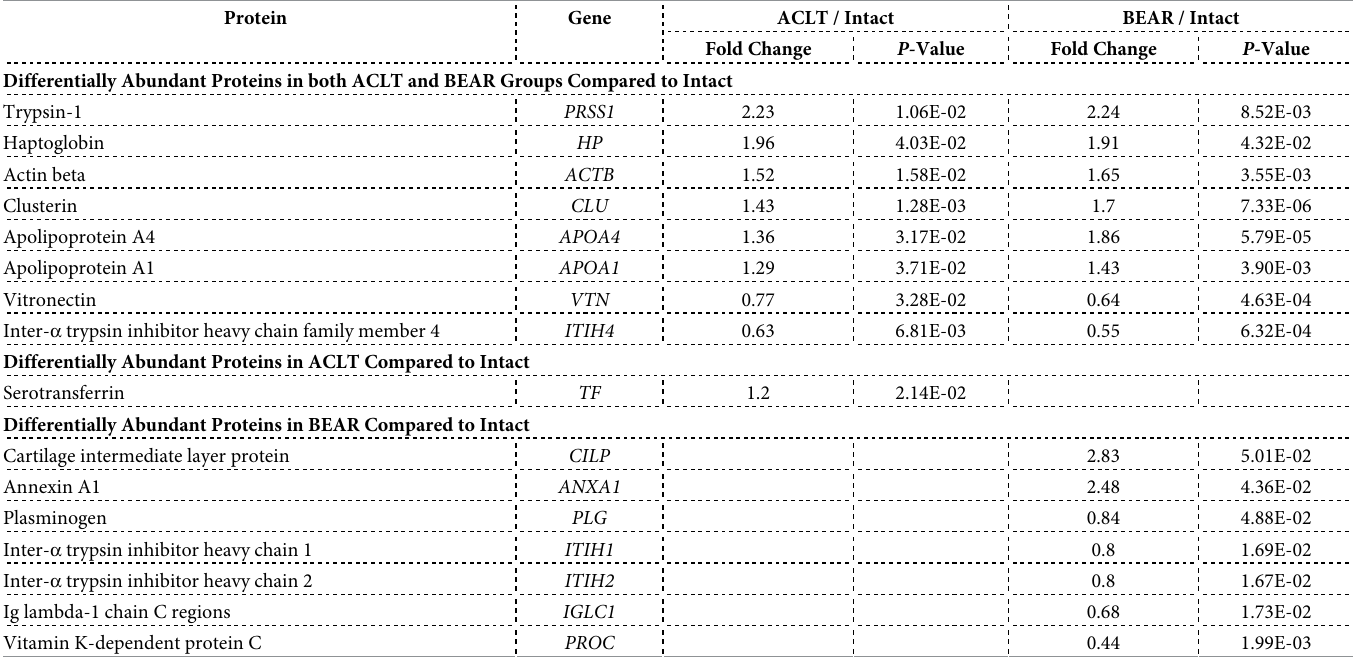
Table 3. Secreted proteins that are significantly different in abundance in ACLT and/or BEAR knees compared to intact group at 12 months. Fold change values represent the ratio of detection in the ACLT or BEAR group versus intact group; thus a fold change greater than 1 reflects higher protein abundance in the synovial fluid of the ACLT or BEAR group and a fold change less than 1 reflects higher protein abundance in the synovial fluid of the intact